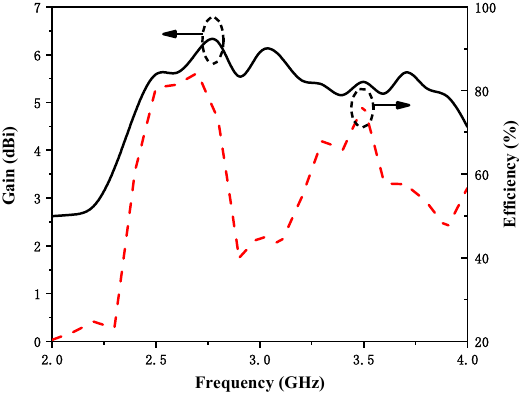
Figure 8. Measured antenna peak gain and total efficiency.